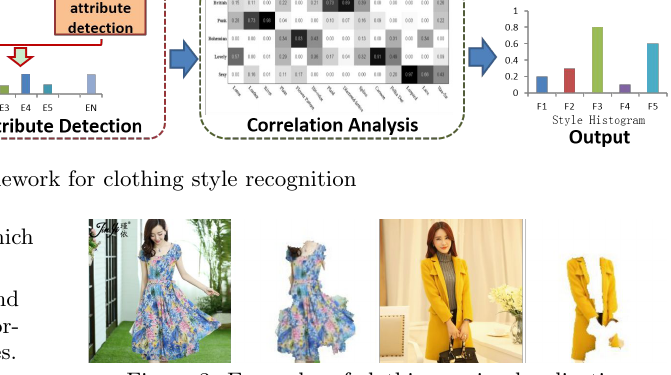
Figure 3: Examples of clothing region